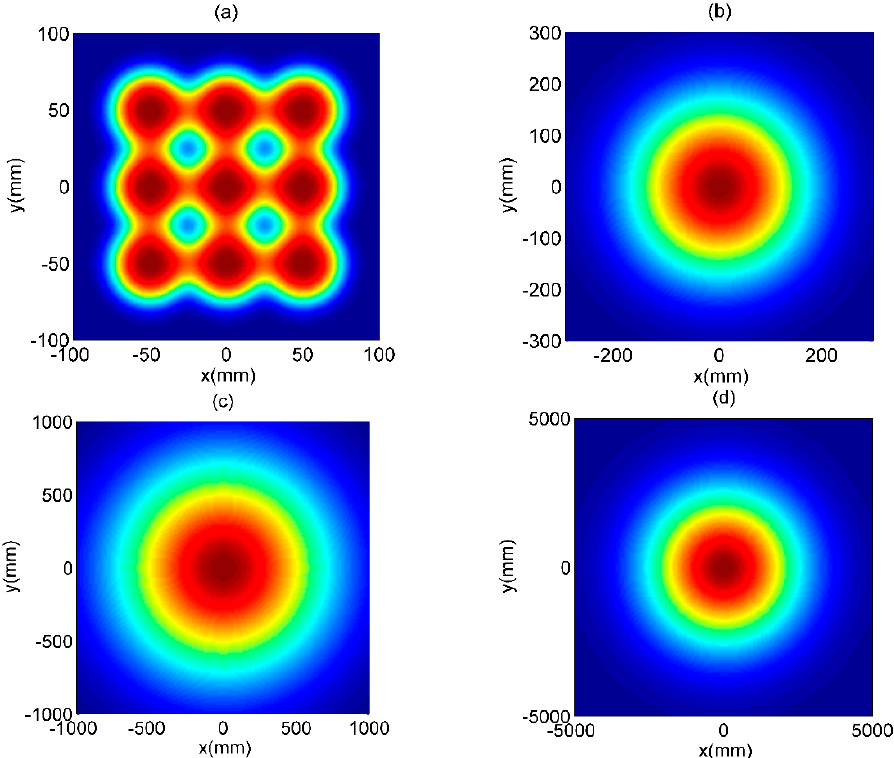
Figure 3. The contour graphs of N × D MGSM array beams propagating through non- Kolmogorov turbulent atmosphere with N = D = 3. ( a ) z = 100 m, ( b ) z = 600 m, ( c ) z = 2000 m, and ( d ) z = 5000 m. Appl. Sci. 2020 , 10 , x FOR PEER REVIEW